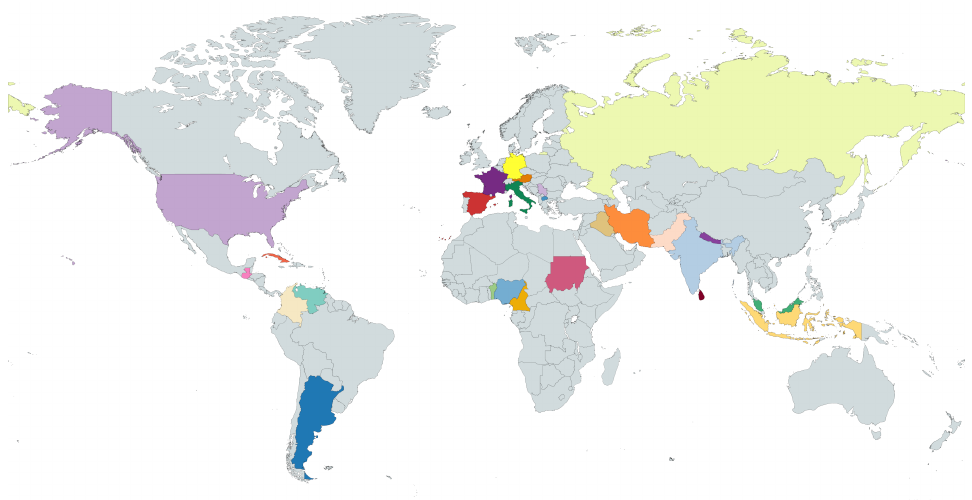
Figure 1. Geographical distribution of school’s participants and faculty members. Represented countries are shown in